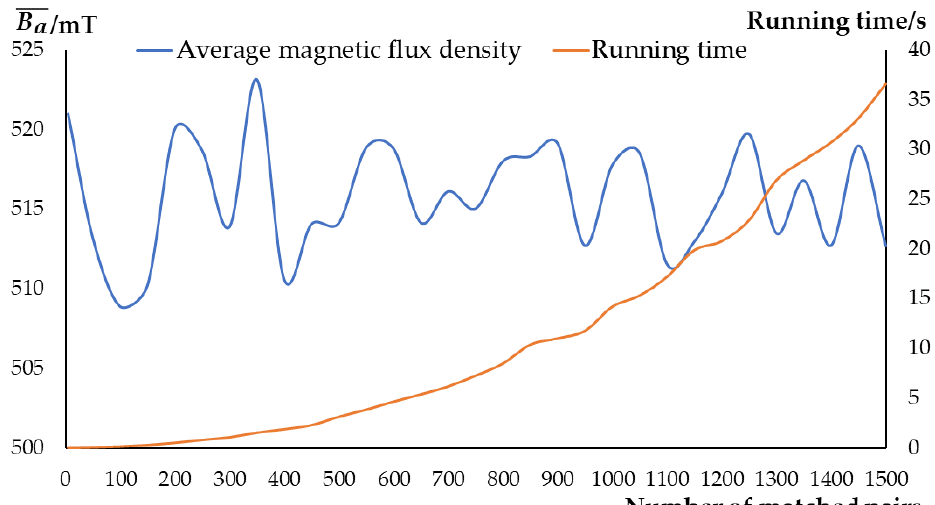
Figure 7. Numerical experiment result.